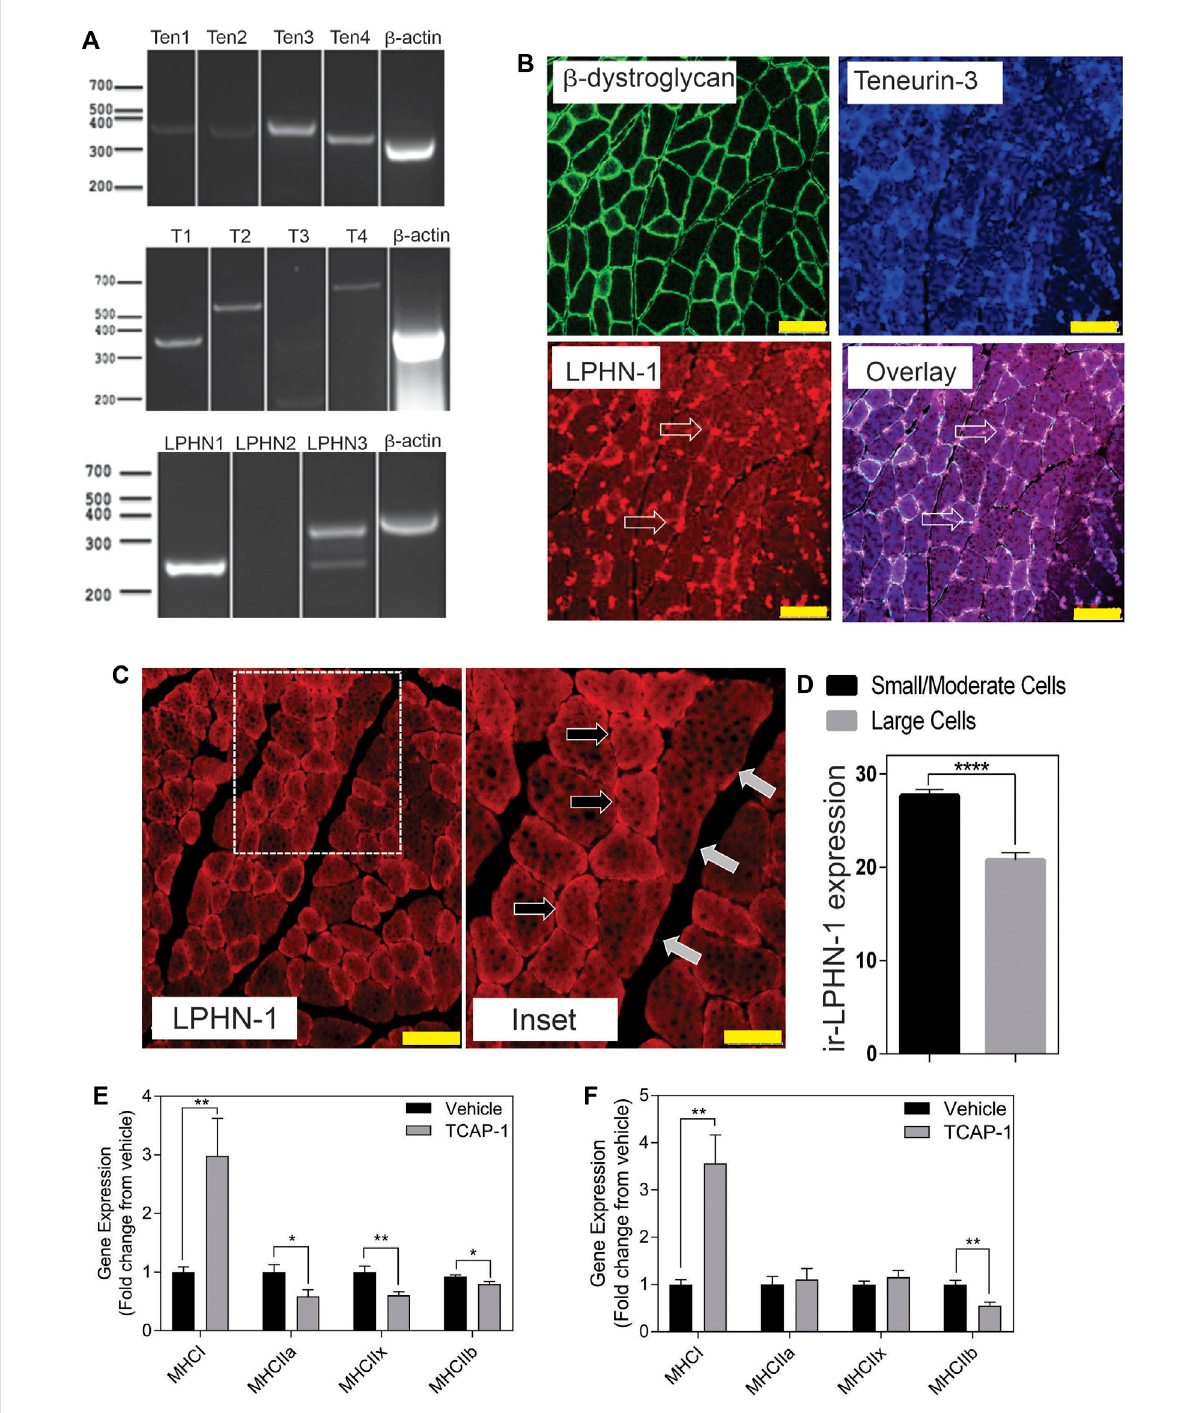
FIGURE 3 Expression of theteneurin/TCAP-LPHN immunoreactivity(ir) inrat skeletal muscle: (A) . PCR expression of teneurins,TCAP and LPHNs inrat TA muscle. (B) .Immunologicalexpressionof β -dystroglycan,teneurinandLPHNinratskeletalmuscle.Arrowsindicatenodesofaggregation(Scalebar: 100 µM). (C) . Enhanced examination of ir-LPHN regions in TA muscle cells. Left panel scale bar indicates 100 μ M, whereas the right panel scale bar indicates 50 µM. Black arrows indicate cells with high LPHN-1 labelling, whereas white arrows indicate cells of low LPHN-1 labelling. (D) . Quanti fi cationofir-LPHN-1asafunctionofmusclecelldiameter(size)asshownin “ C ” (Student ’ s t -Test p < 0.0001;****). (E) .Changesin fi bertypein short-term TCAP-1 administration ( t -test indicated for each pair). (F) . Changes in fi ber-type over long-term TCAP-1 administration ( t -test indicated for each